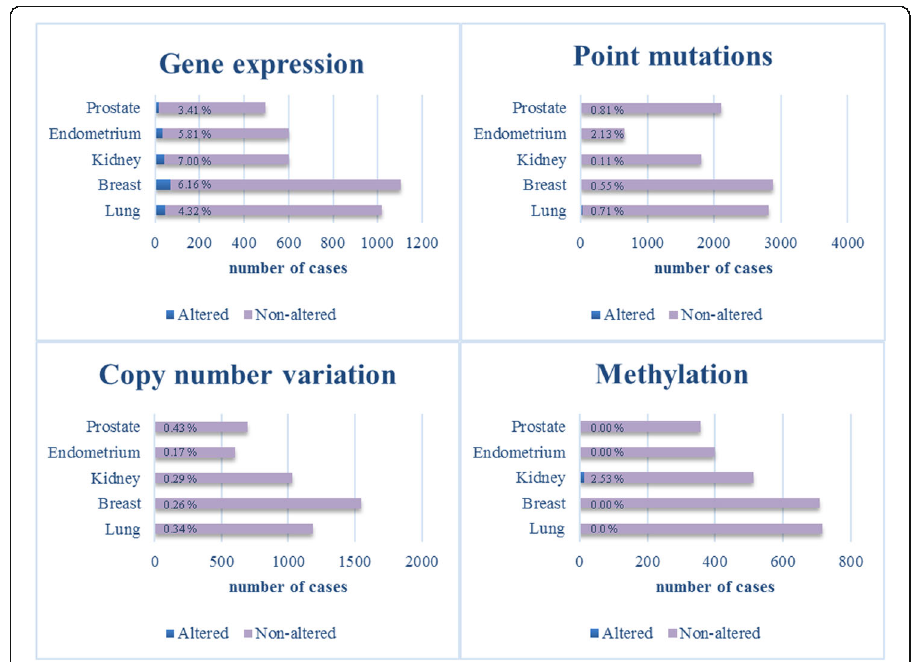
Fig. 4 STAT3 mutational status. The table showing the distribution of mutations across the primary tissue types that are curated by COSMIC database was used as template. Only cancer types with all mutation types included were chosen for this picture [118]